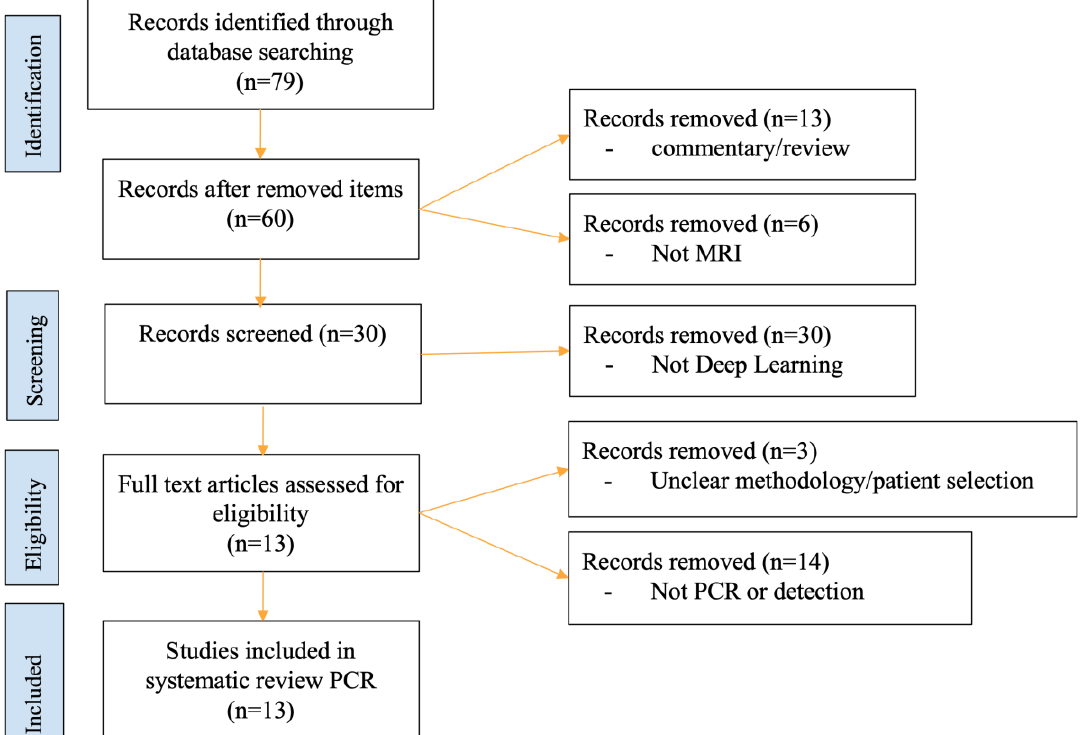
Figure 1. PRISMA flowchart. Initially, 79 studies were found on PubMed through our keyword search, of which 66 were removed. The final number of papers reviewed was 13.